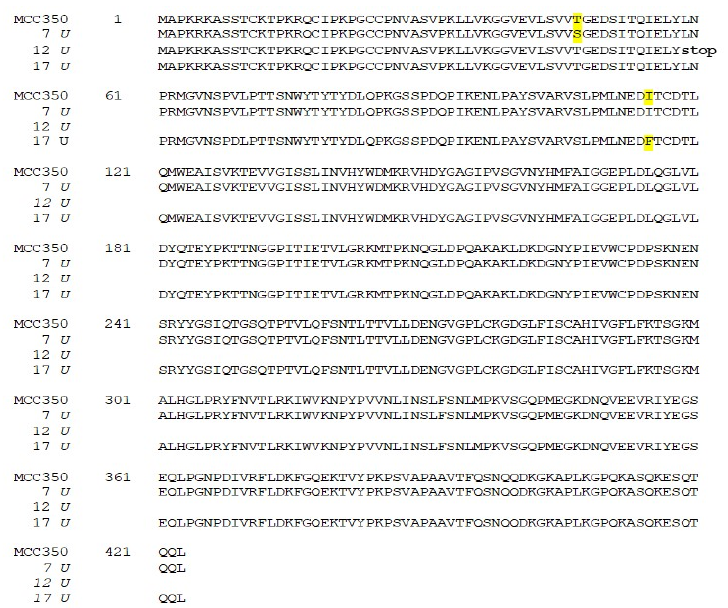
Figure 4. Amino-acid analysis of MCPyV VP1 in urine samples. The amino-acid translation of MCPyV VP1 nucleotide sequences revealed a VP1 characterized by Ther47Ser substitution in 7 U and by the presence of Ile115Phe substitution in 17 U (highlighted in yellow). A single nucleotide deletion in the VP1 sequence of 12 U transformed an out-of-frame stop codon into an in-frame stop codon, resulting in translation of a truncated VP1 of 58 residues.